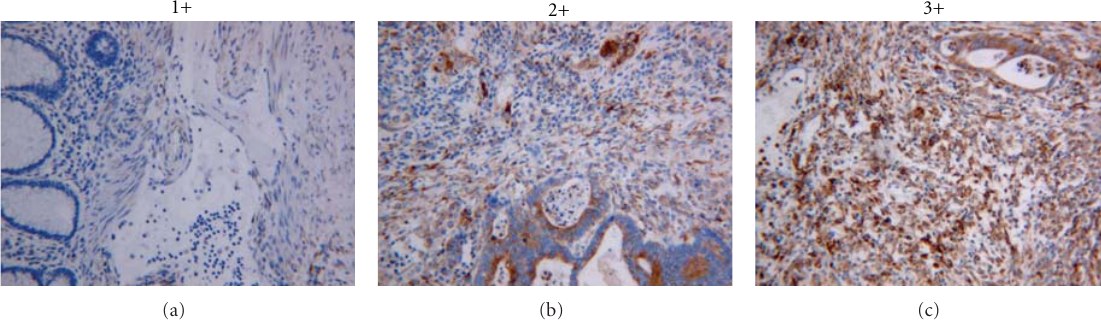
Figure 4: The expression of Cx43 in colonic stroma was evaluated according to the intensity of the staining as follows: 1, very weak expression (1+); 2, moderate expression (2+); 3, strong expression (3+) (original magnification ×